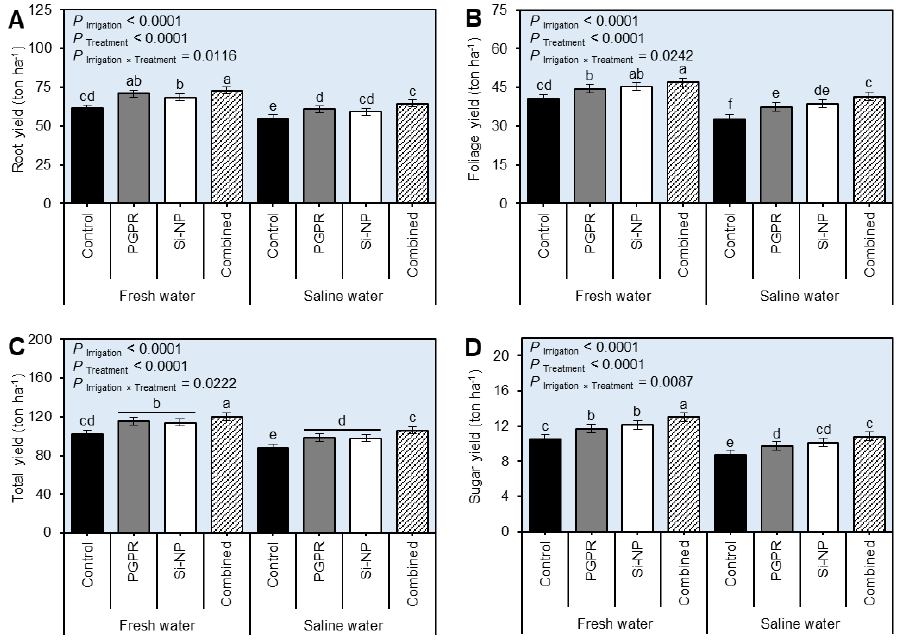
Figure 7. Effect of seed inoculation with PGPR and/or Si-NP foliar application on the water relations and chlorophyll reading of sugar beet plants grown in salt-affected soil and subjected to saline water irrigation during the 2019/2020 seasons. ( A ) Root yield (ton ha −1 ), ( B ) foliage yield (ton ha −1 ), ( C ) total yield (ton ha −1 ), and ( D ) sugar yield (ton ha −1 ) during the 2019/2020 seasons, respectively. Data presented are the means ± standard deviation (mean ± SD) of three biological replicates. Different letters signify statistically significant differences between treatments according to Tukey’s HSD test ( P Irrigation × Treatment ≤ 0.05).